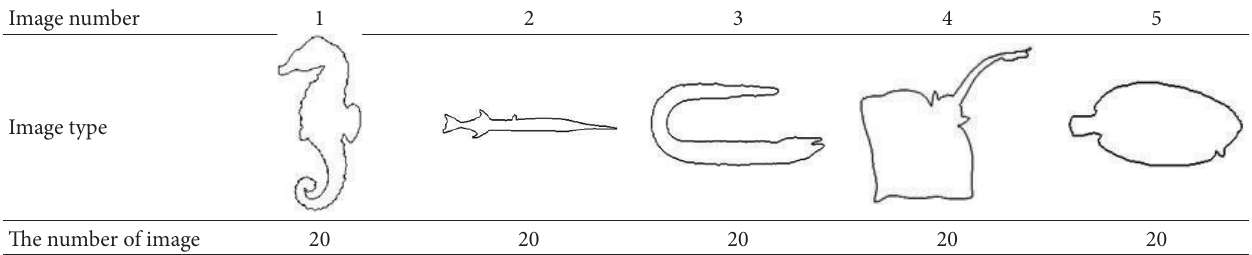
Table 1: Some images in image database of SQUID.